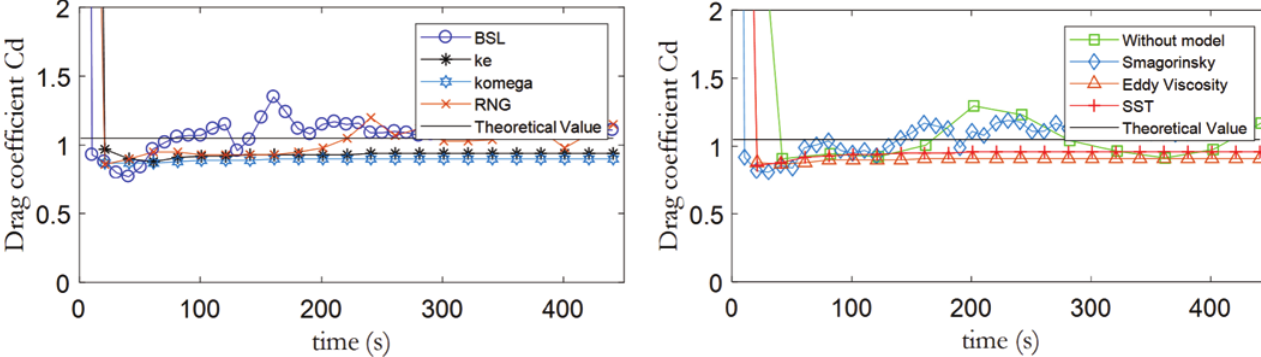
Convergence test of different turbulence models — cube (Model